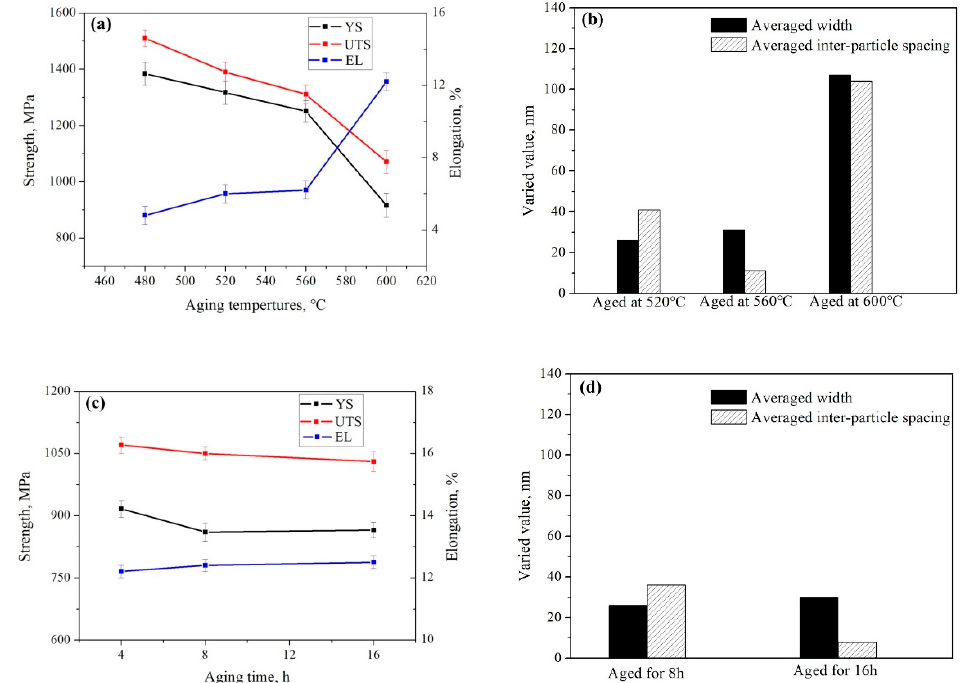
Figure 10. ( a ) Tensile properties of the alloy aged at 480 °C, 520 °C, 560 °C and 600 °C for 4 h; ( b ) varied values of the averaged width and inter-particle spacing of intragranular α in the alloy aged 520 °C, 560 °C and 600 °C for 4 h; ( c ) tensile properties of the alloy aged at 600 °C for 4 h, 8 h and 16 h; ( d ) varied values of average width and inter-particle spacing of intragranular α in the alloy aged at 600 °C for 8 h and 16 h.